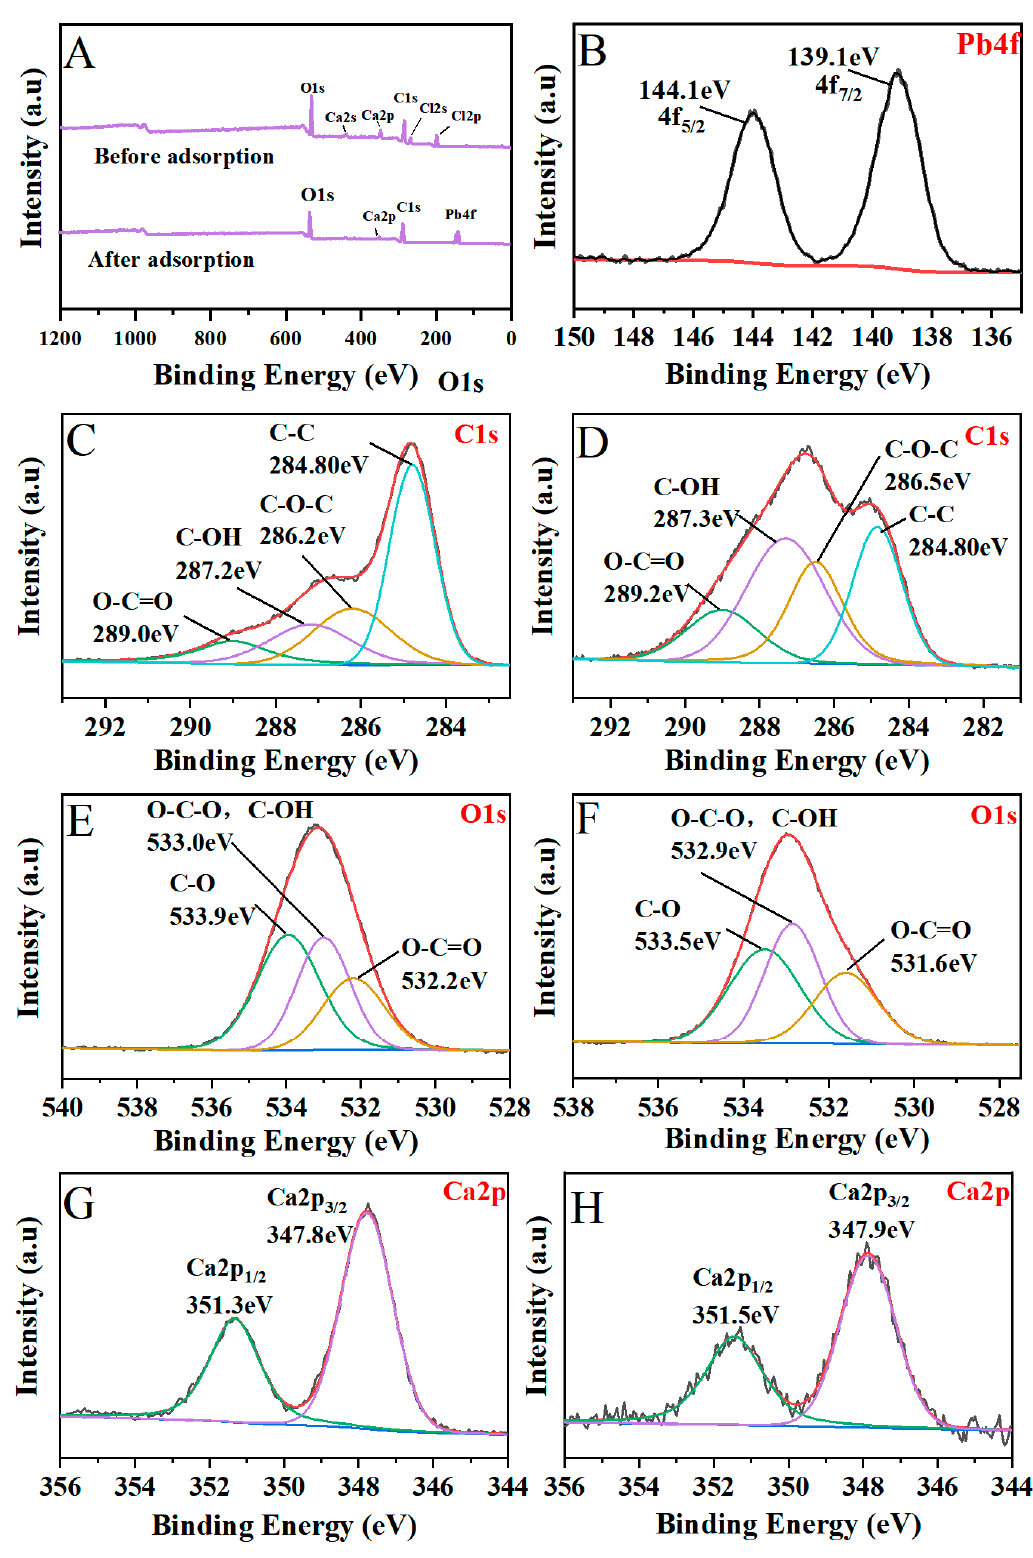
Figure 9. Wide-scan XPS spectra of P/AC 2:3 before and after adsorption ( A ). High-resolution XPS spectra of Pb4f of P/AC 2:3 after adsorption ( B ). O1s before ( C ) and after ( D ) adsorption, C1s before ( E ) and after ( F ) adsorption. Ca2p before ( G ) and after ( H ) adsorption.